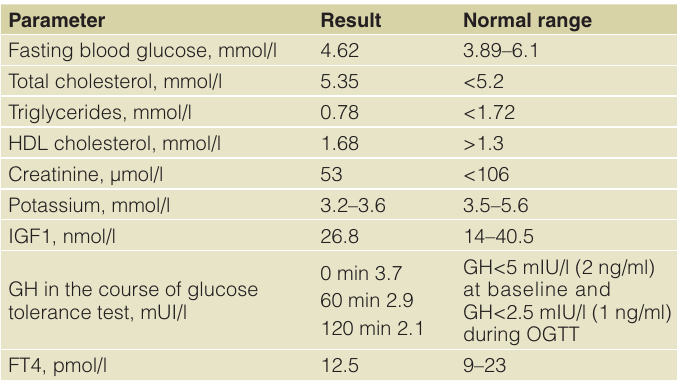
Table 1. Biochemical and hormonal parameters at diagnosis of primary